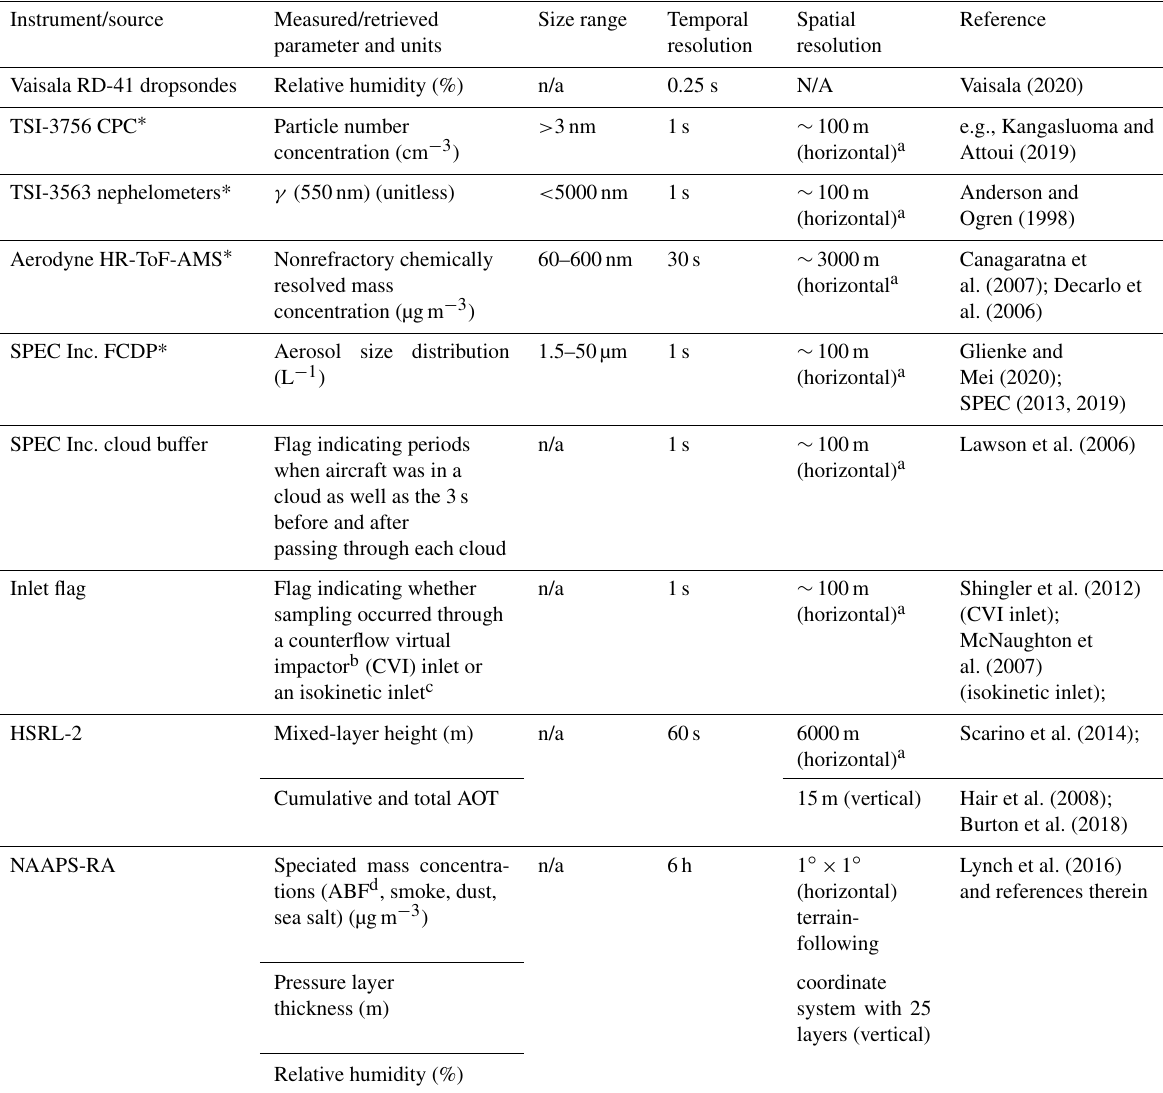
Table 1. Summary of datasets used in this study. “n/a” stands for not